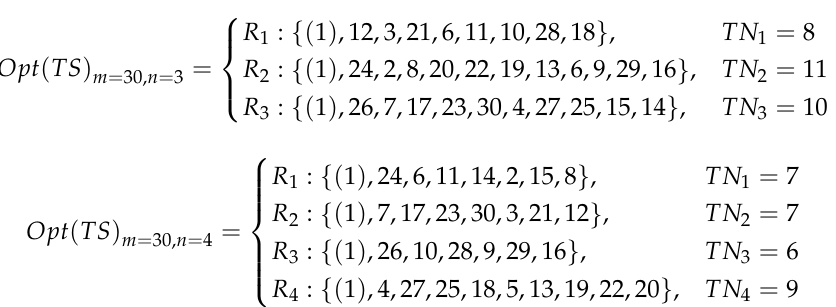
Table 1. Comparison of algorithm parameters from Experiment 1. Algorithm